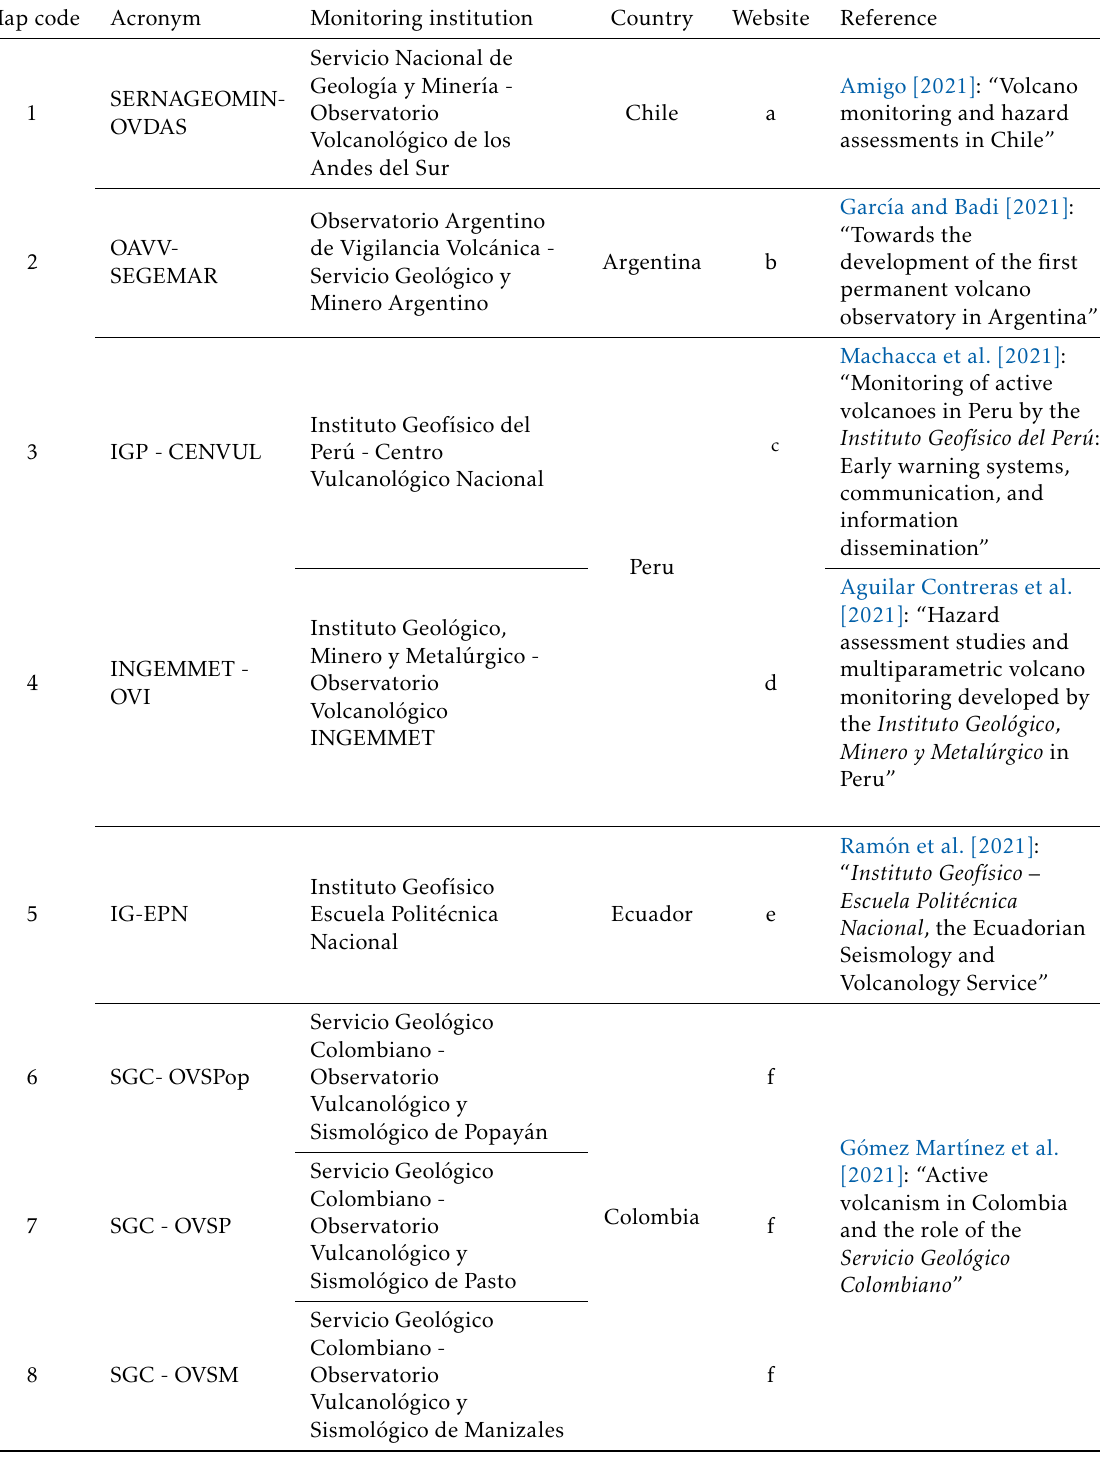
Table 1: Latin American volcano observatories, listed from south to north. Map